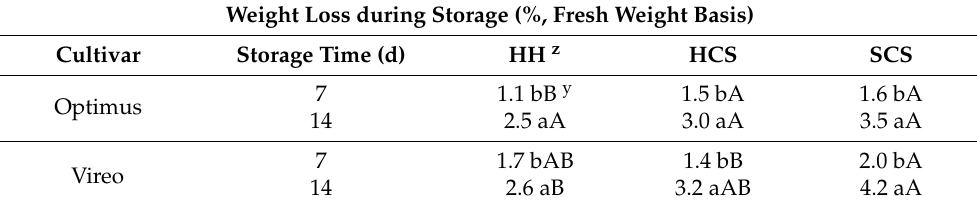
Table 5. Weight loss during storage for 14 d at 1 ◦ C for “Optimus” and “Vireo” blueberries after hand harvest or mechanical harvest onto hard- or soft-catch surfaces and commercial packing. Harvest